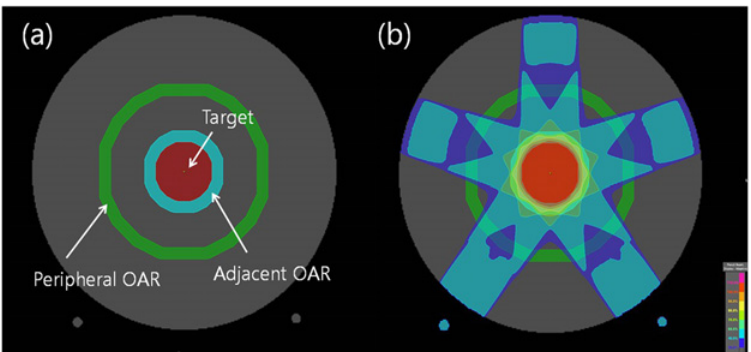
Fig 1. Axial slices of the ArcCHECK CT phantom with the target, adjacent organ at risk (OAR), and peripheral OAR (a). Five portals were used for the planning to cover 95% of the target volume with the prescribed dose. The beam angles were 0°, 72°, 144°, 216° and 288° (b).